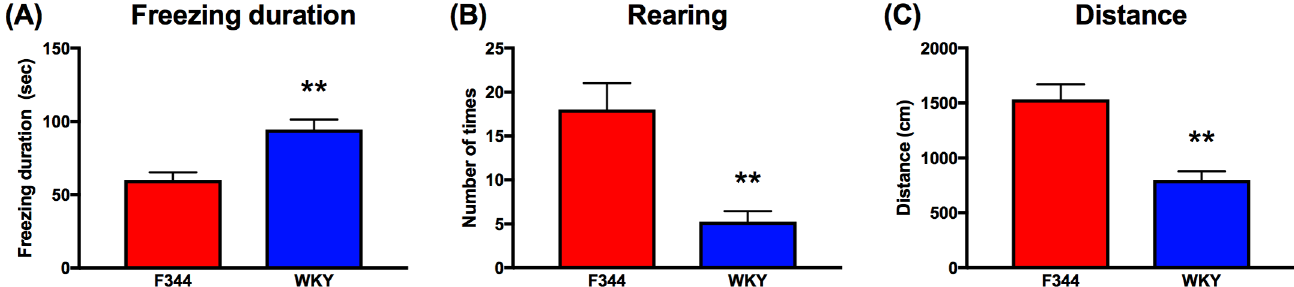
Fig 1. Behavioral responses to footshock of F344 and WKY adult male rats. (A) WKY adult male rats froze longer (freezing duration in seconds) following the footshocks in the CFC conditioning chamber. (B) Number of rears are significantly lower for WKYs compared to F344s. (C) F344s move around the chamber after the footshock significantly more than WKYs measured by distance traveled in cm. Data are presented as mean ± standard error of mean. N = 16 per group. (cid:3)(cid:3) P < 0.01 by Student’s t